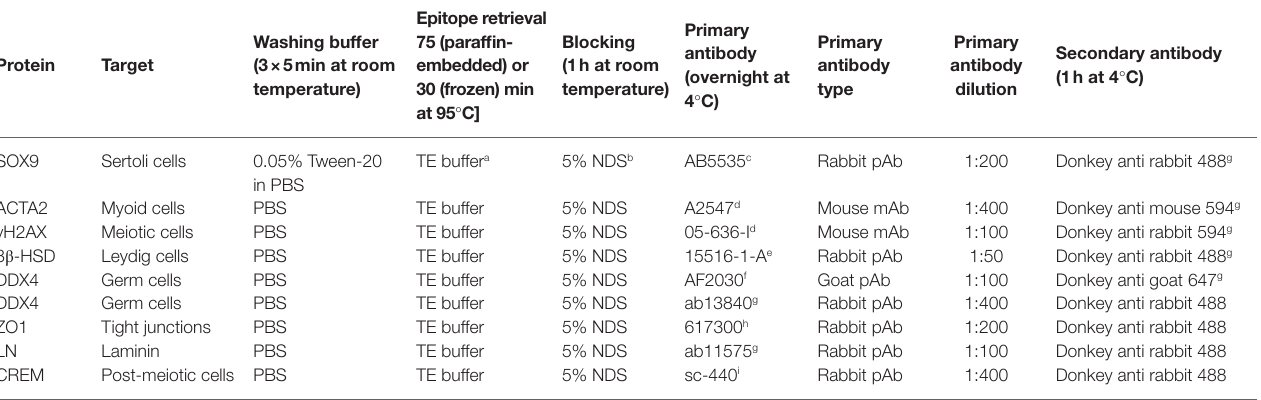
TABLE 1 | Antibody information and reagents used for immunofluorescent stainings.